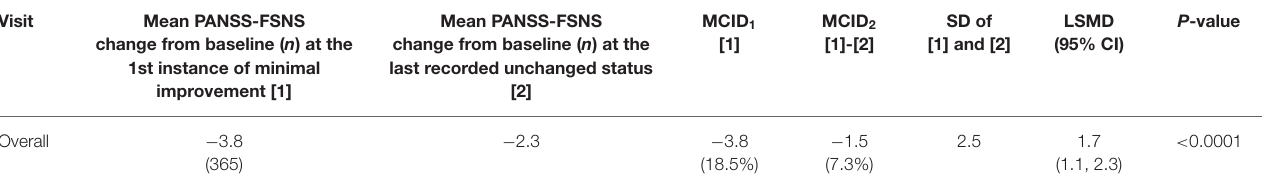
identified a − 3 point decrease from the PANSS-FSNS at baseline as the cut-off value most effectively differentiated between true positive and false positive classifications, i.e., minimally improved and unchanged statuses ( Figure 3 ). The odds ratio (OR) indicates the strength of association between the decrease in FSNS and the improved state based on CGI-I. For the − 1.7 shift in FSNS obtained above as estimated MCID